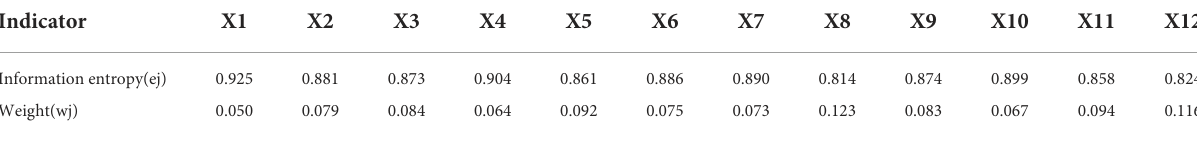
TABLE 7 Information entropy and weight distribution of each indicator.